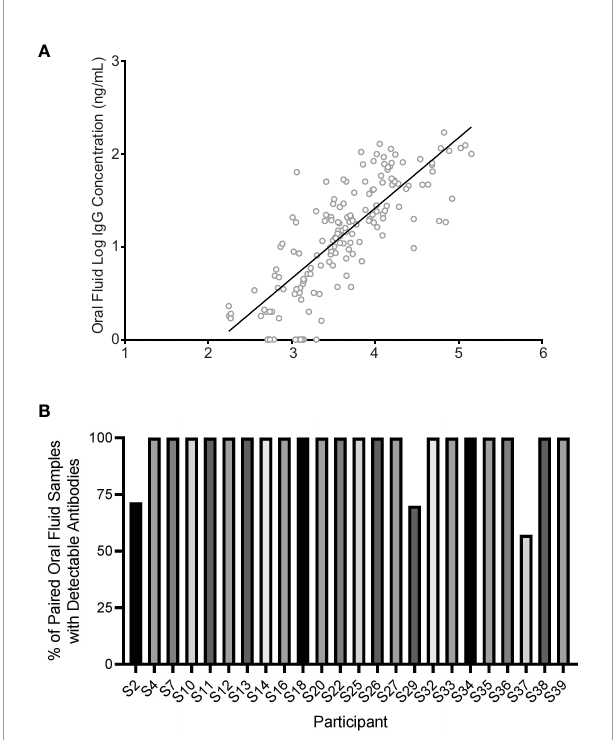
FIGURE 4 | SARS-CoV-2 IgG in oral mucosal fl uids of participants (n = 24) correlated with that of their serum. (A) Oral mucosal fl uid IgG increased with serum IgG in the participants (R 2 = 0.64, p < 0.0001). Each data point represents a single timepoint collection for both serum and oral mucosal fl uids for a speci fi c participant. The regression line is shown as the solid line. (B) Correlation between antibody detection in participants with paired serum and oral fl uid specimens was typically high. On an individual basis, three individuals with detectable SARS-CoV-2 antibodies in serum (S2, S29, and S37) developed detectable oral mucosal fl uid antibodies and maintained detectable antibody levels later in the time